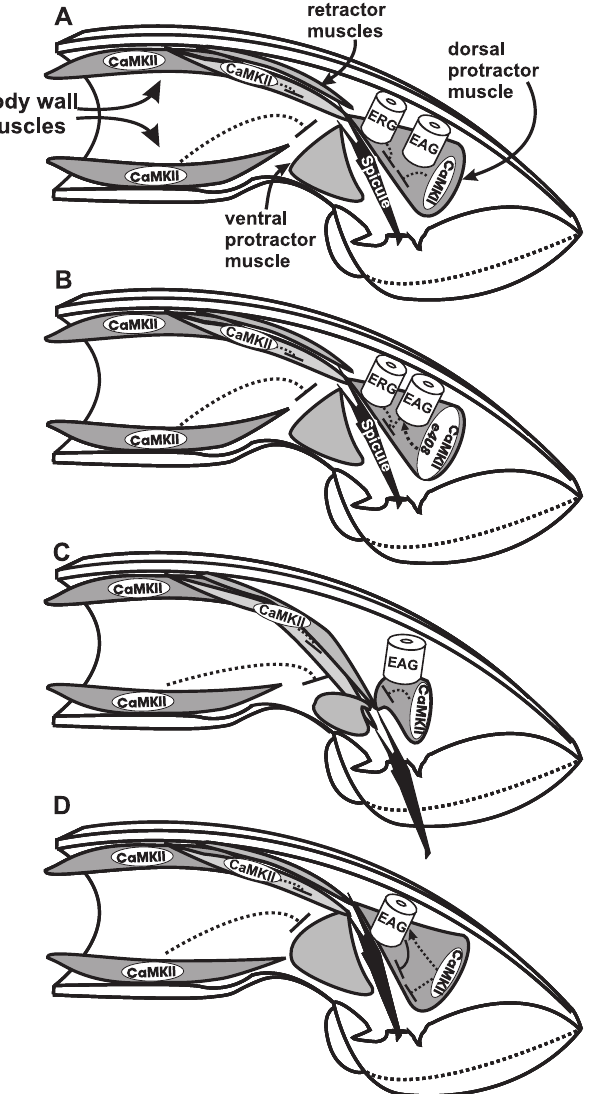
Figure 4. Dietary Deprivation Suppresses Spontaneous Muscle Contrac- tions Using CaMKII and EAG K þ Channels Cartoon view of the right half of the male tail. CaMKII is expressed in body-wall muscles, and dorsal and ventral spicule protractor and retractor muscles. EAG and ERG-like K þ channels are expressed in both dorsal and ventral spicule protractor muscles. CaMKII, EAG, and ERG-like K þ channels are depicted only in the dorsal protractor muscles for visual clarity. (A) When males are well-nourished, CaMKII/UNC-43 and ERG-like K þ channel/UNC-103 act redundantly in body-wall and sex muscles to keep the spicule protractor muscles from spontaneously contracting. (B) The CaMKII mutant allele e408 upregulates EAG and ERG-like K þ channels in the spicule protraction circuit while disrupting the ability of CaMKII to phosphorylate other unknown substrates. (C) In the absence of functional ERG-like K þ channel/UNC-103, CaMKII/ UNC-43 activity is not sufficient to inhibit spontaneous spicule muscle contraction in 30%–40% of well-nourished males. (D) When males are food deprived, CaMKII/UNC-43 and EAG K þ channels compensate for defective ERG-like K þ channel/UNC-103 and suppress spontaneous muscle